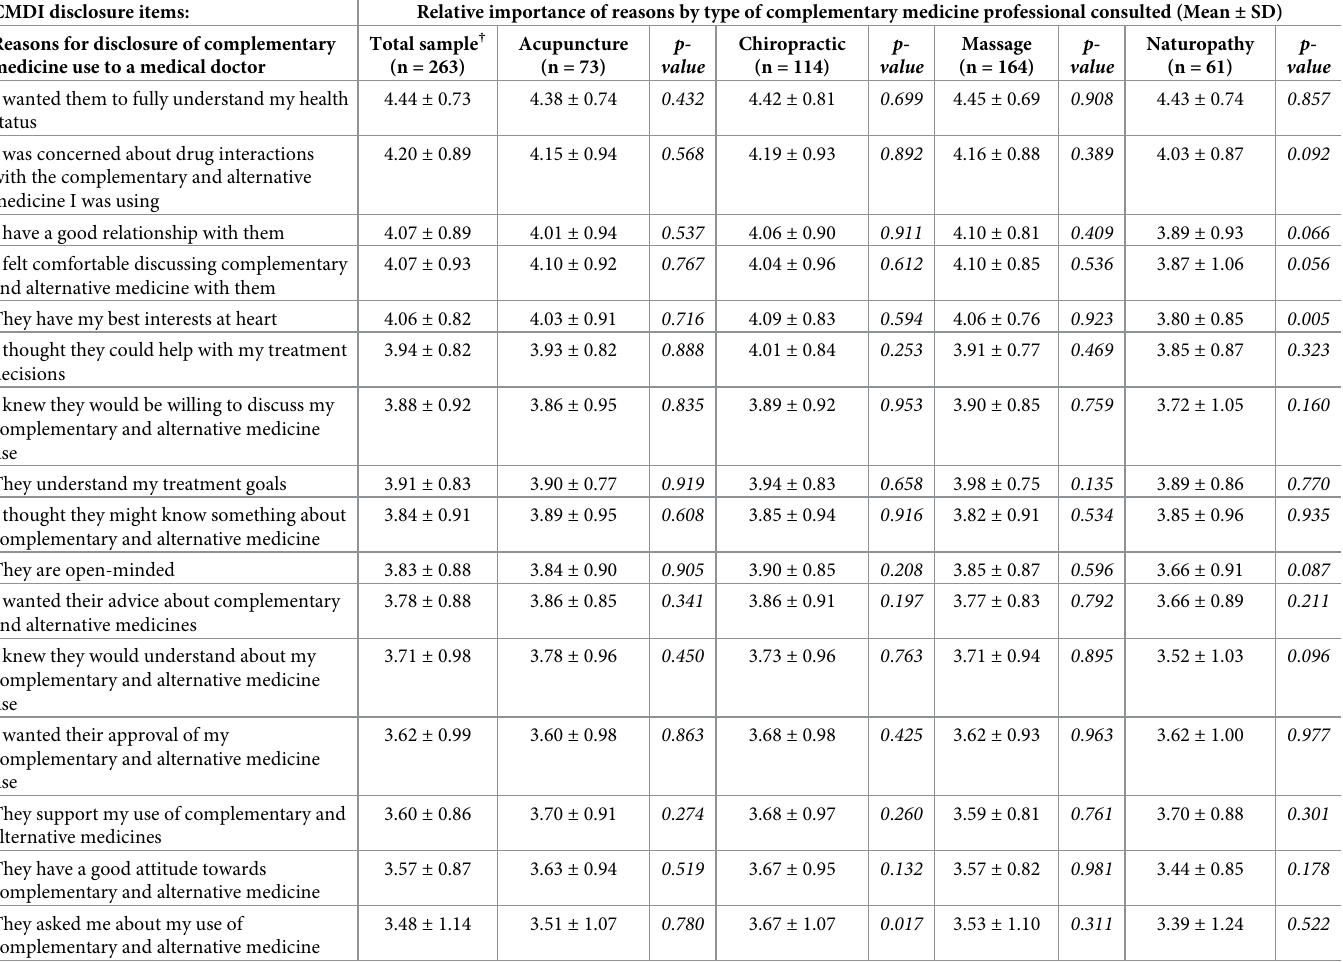
Table 3. T-test showing differences in reasons for disclosure of complementary medicine use to medical doctors for each type of complementary medicine profes- sional